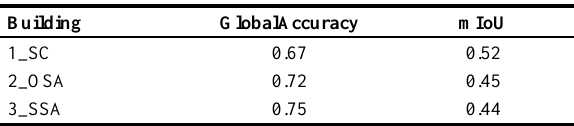
Table 6 . Masking-based methodology